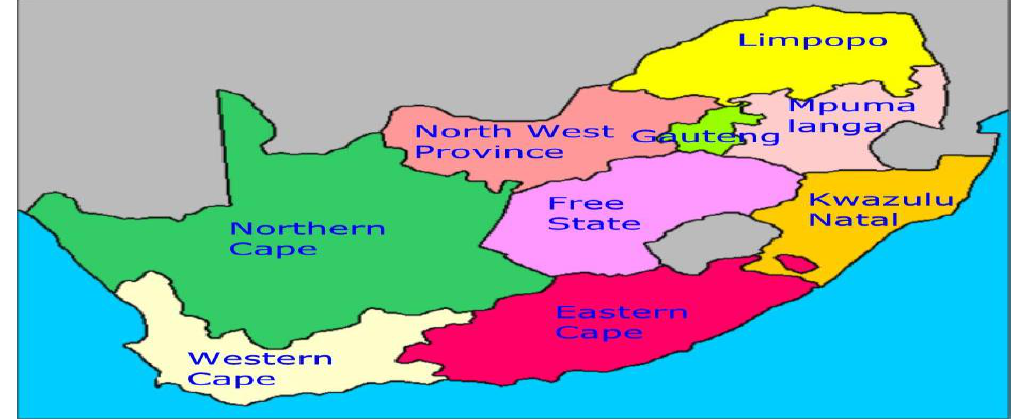
Figure 1. Map of South Africa showing the various provinces. Source: [41].